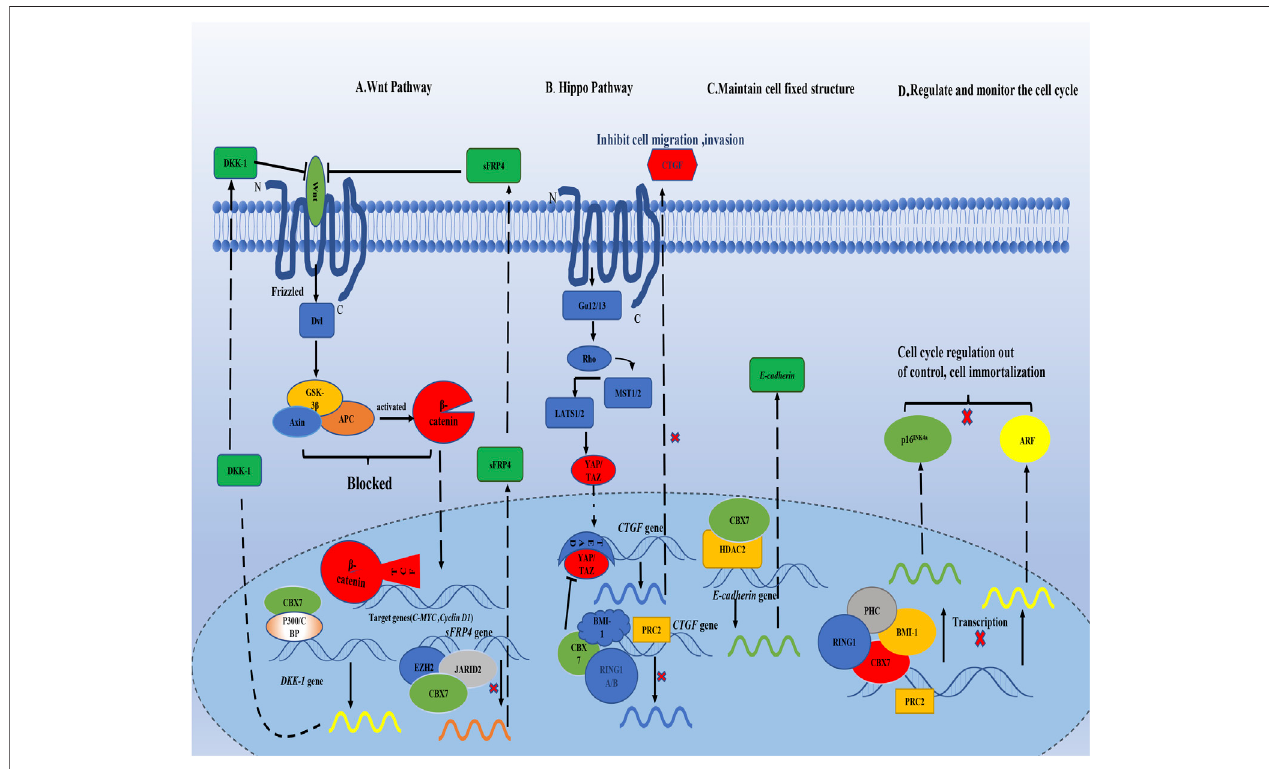
FIGURE 2 | CBX7 interacts with proteins in the nucleus, transcriptionally controls the synthesis of related proteins, and regulates different signaling pathways. (A) CBX7 enhances the expression of Wnt antagonist DKK-1 by interacting with other molecules in epigenetics, leading to the blockage of downstream signal transduction of Wnt pathway, and then the expression ofC-MYC and Cyclin D are restricted to maintain normal cell proliferation. But CBX7 inhibits the expression of sFRP4, which is also a Wnt antagonist. (B) On the one hand, CBX7 directly inhibits CTGF expression epigenetically; on the other hand, CBX7 antagonizes YAP/TAZ to indirectly restrictCTGFexpression,whichinhibitscellinvasionandmigration. (C) CBX7cooperateswithHDAC2topromotethesynthesisofE-cadherinintranscriptiontomaintain cell fi xed structure. (D) CBX7 relies on PRC1, and cooperates with PRC2 to epigenetically inhibit the expression of INK4a/ARF, making cell proliferation out of